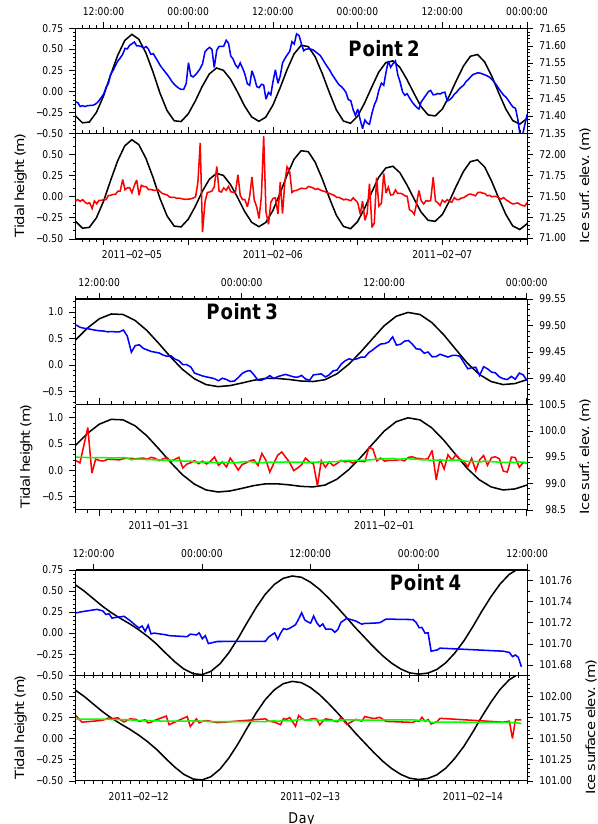
Figure 14. Comparison of the upper surface displacements and tides for point 2, 3 and 4. Black curves represent the tidal amplitude whereas the red ones stand for raw RTK GPS positions. Blue curves result from a 10-point smoothing of the raw data to which a verti- cal amplification has been applied (varying according to the point) in order to confirm or deny any correlation with the tides. Green curves for points 3 and 4 just represent the smoothing of raw GPS